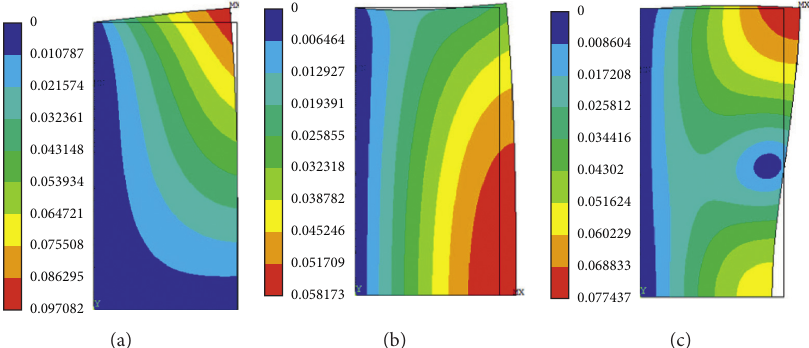
Figure 3: Shapes of the first three modes of the moderately horizontally damaged polymer cutoff wall. (a) First vibration mode. (b) Second vibration mode. (c) Third vibration